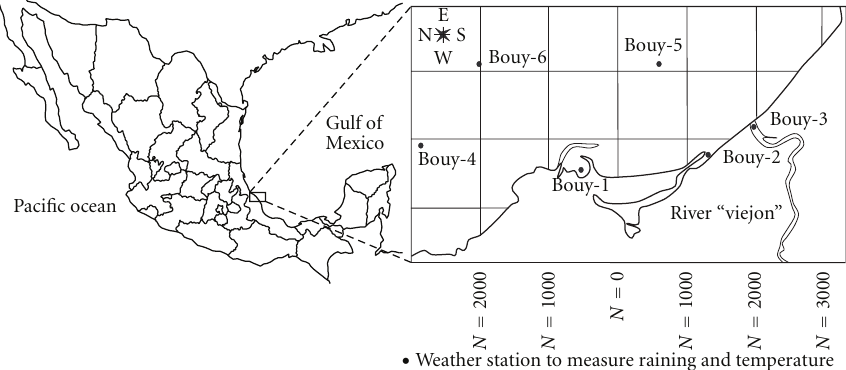
Figure 10: Location map of the study area and the location of the weather stations.